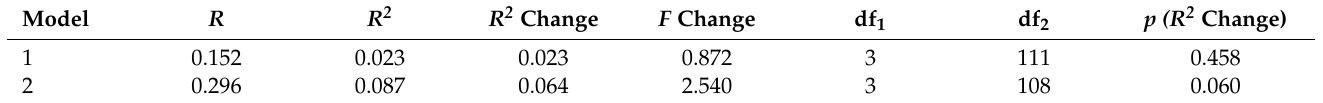
Table 3. R and R 2 change from Models 1 and